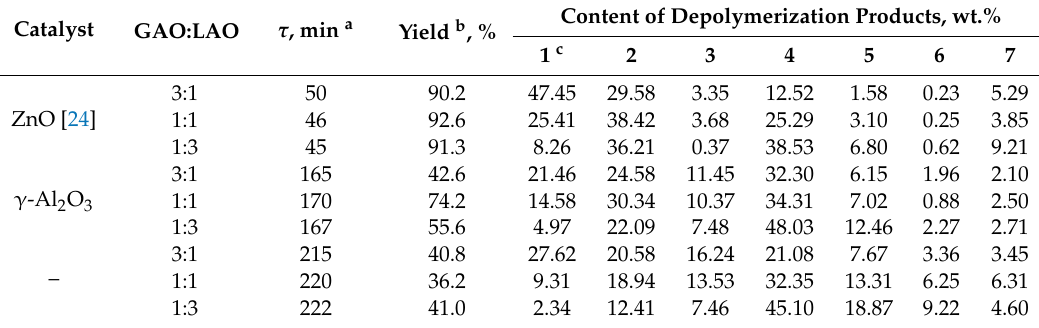
Table 3. Yield and composition of products of depolymerization of GAO:LAO mixtures.